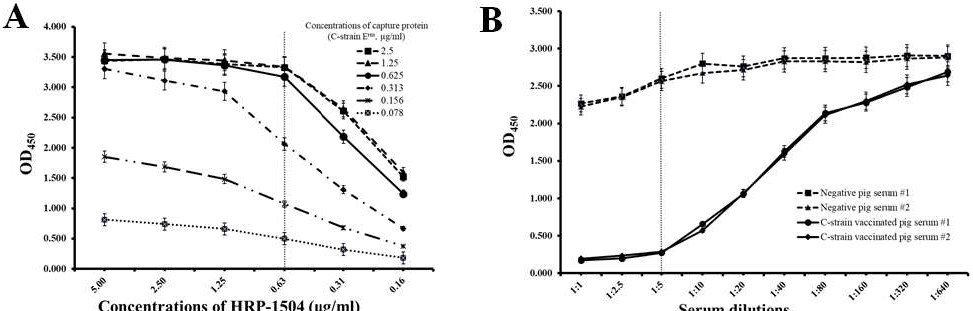
Figure 2. Determination of concentrations of capture antigen and competitive antibody, and dilution of serum. ( A ) Determination of optimal concentrations of capture protein (C-strain E rns ) and competitive antibody (HRP-1504). ( B ) Determination of an optimal dilution of serum. Data are expressed as the mean ± standard deviation from independently repeated experiments.